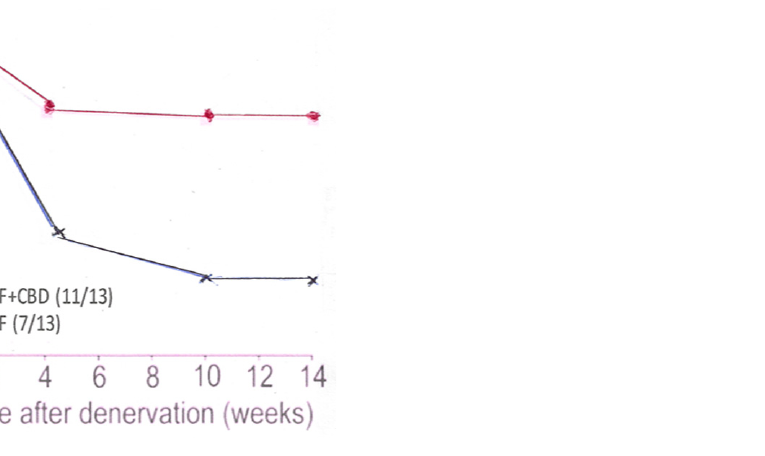
Figure 1. This panel shows the percent survival in CHF animals which had undergone CB denerva- tion (CBD), compared to CHF animals which had not had their CB